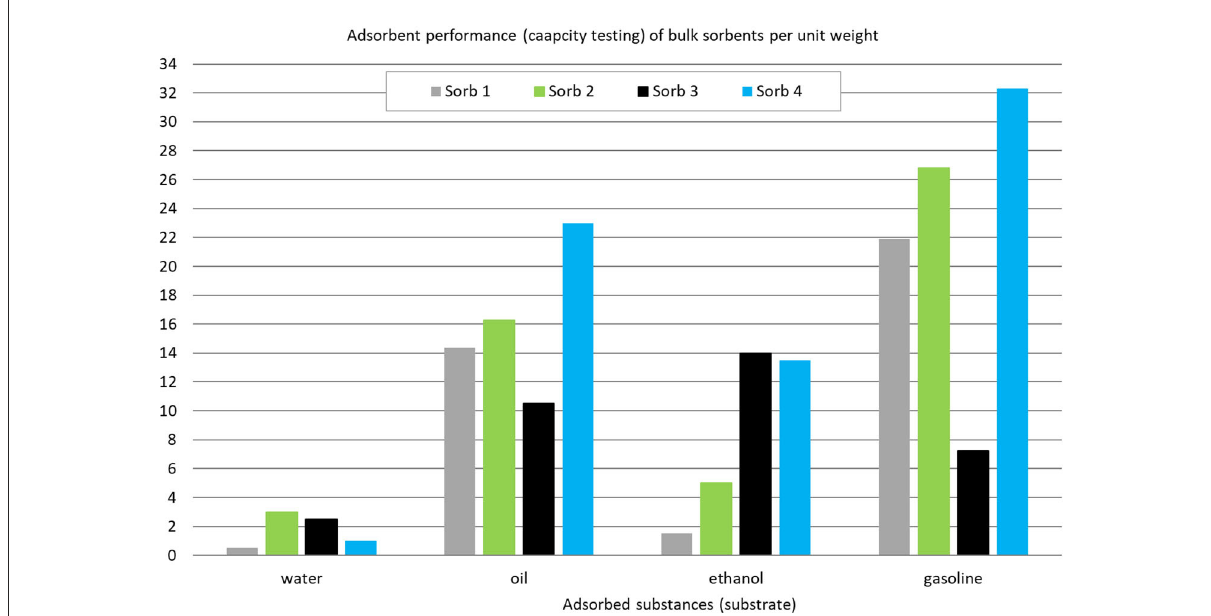
FIGURE4 Comparison of adsorption capacity of loose sorbents per unit mass according to ASTM F716 – 18 (68) after 2h.